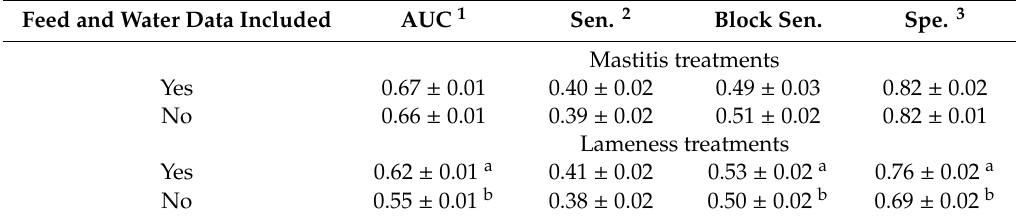
Table 5. Mean AUC, Sensitivity and Specificity ( ± 95%-CI) for classification of treatments with or without inclusion of data from feed and water troughs, means include all machine learning models and sampling methods.